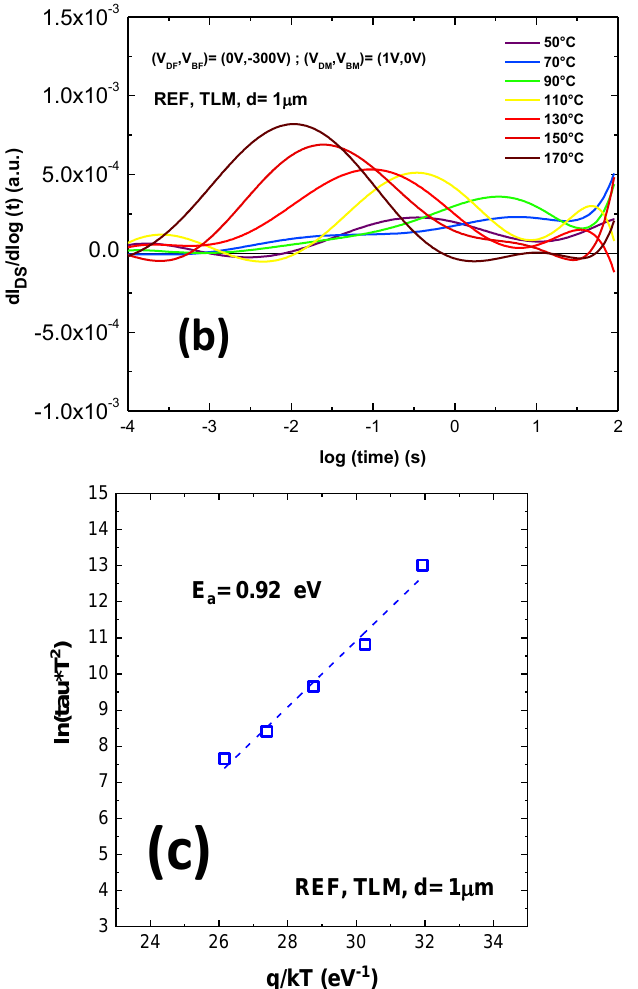
Figure 9. ( a ) Current transient behavior at multiple temperatures from 50 °C to 170 °C on a TLM with distance of 1 μm on the reference sample. ( b ) Time constant spectra corresponding to the current transient and ( c ) Arrhenius plot of the fitting time constants with activation energy of 0.92 eV.